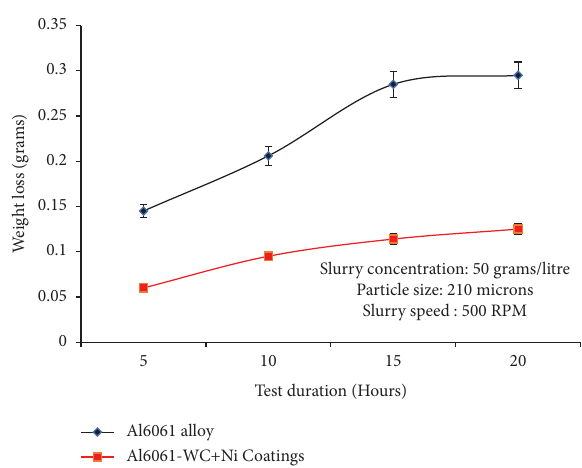
Figure 10: Infuence of test duration on slurry erosive